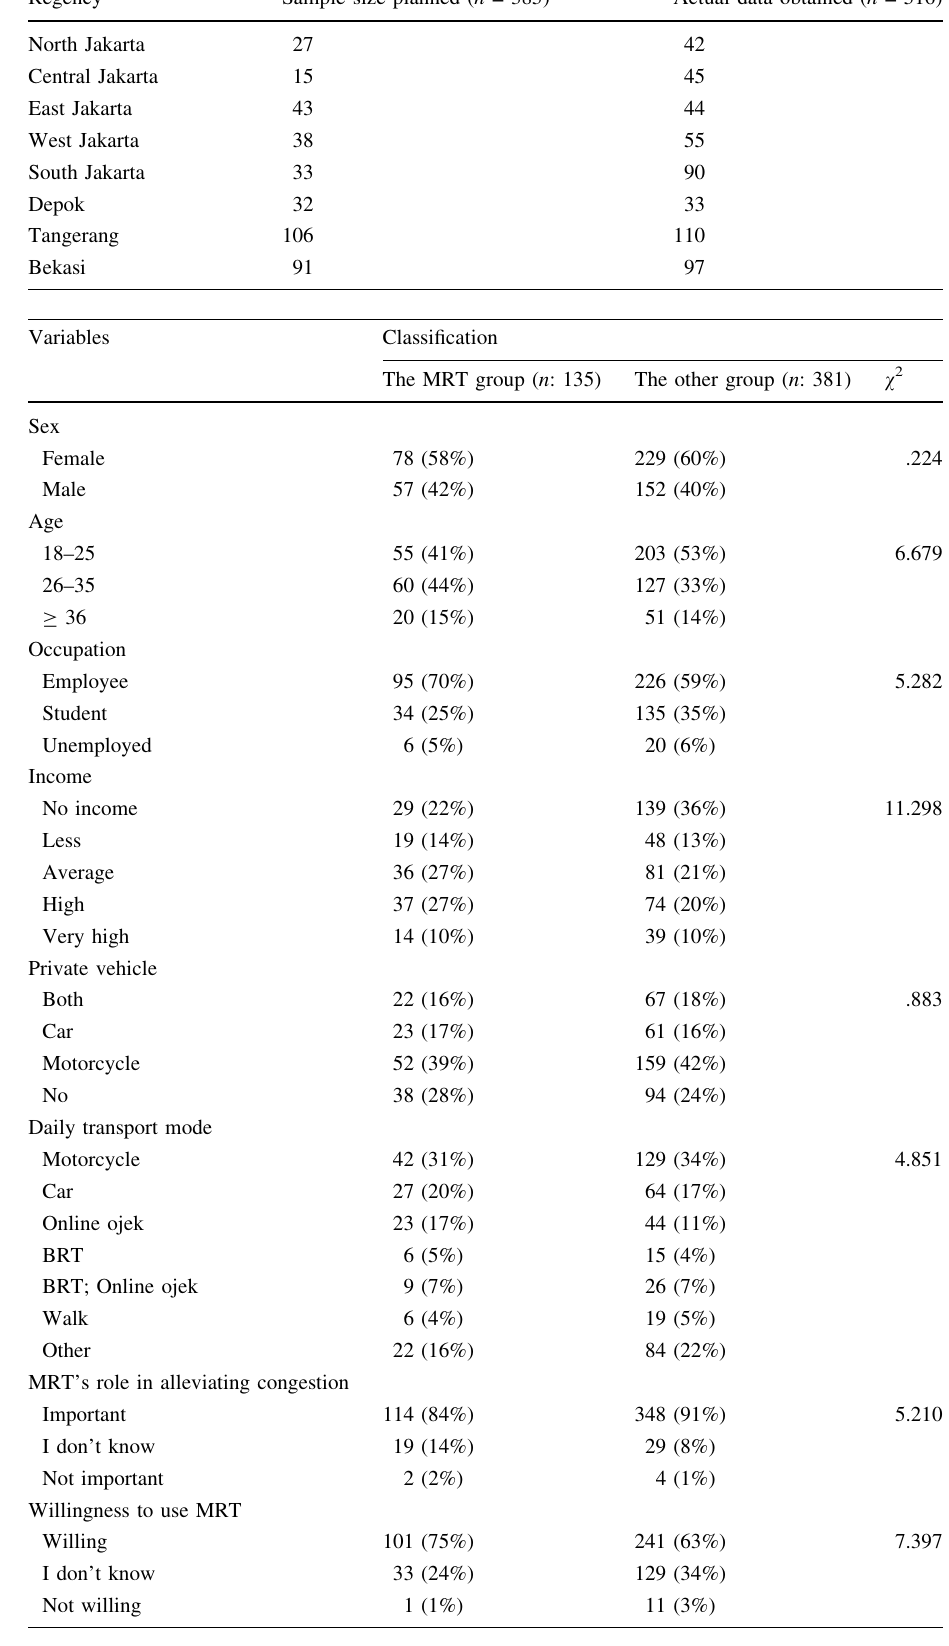
Table 1 Comparison of the sample size planned with the actual data obtained